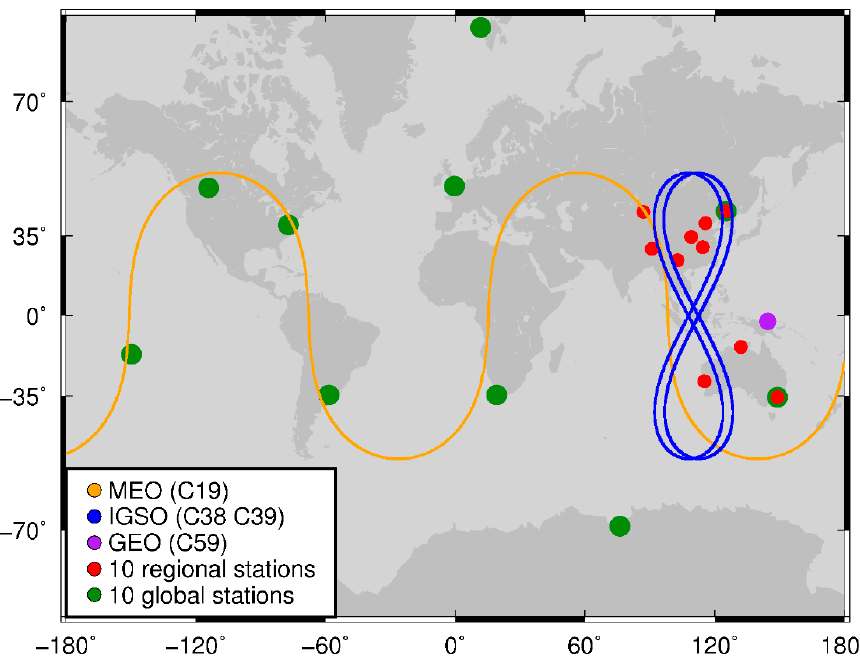
Figure 8. Distribution of 10 regional stations (red dots) and 10 global stations (green dots). The subsatellite points of three types of satellites are marked as orange, blue, and purple, respectively.